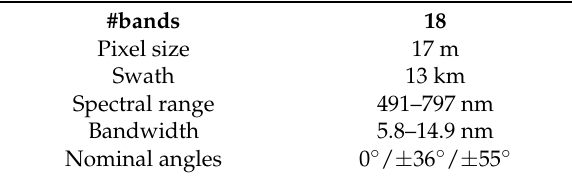
Table 2. Properties of the CHRIS/PROBA Mode 4—vegetation product.